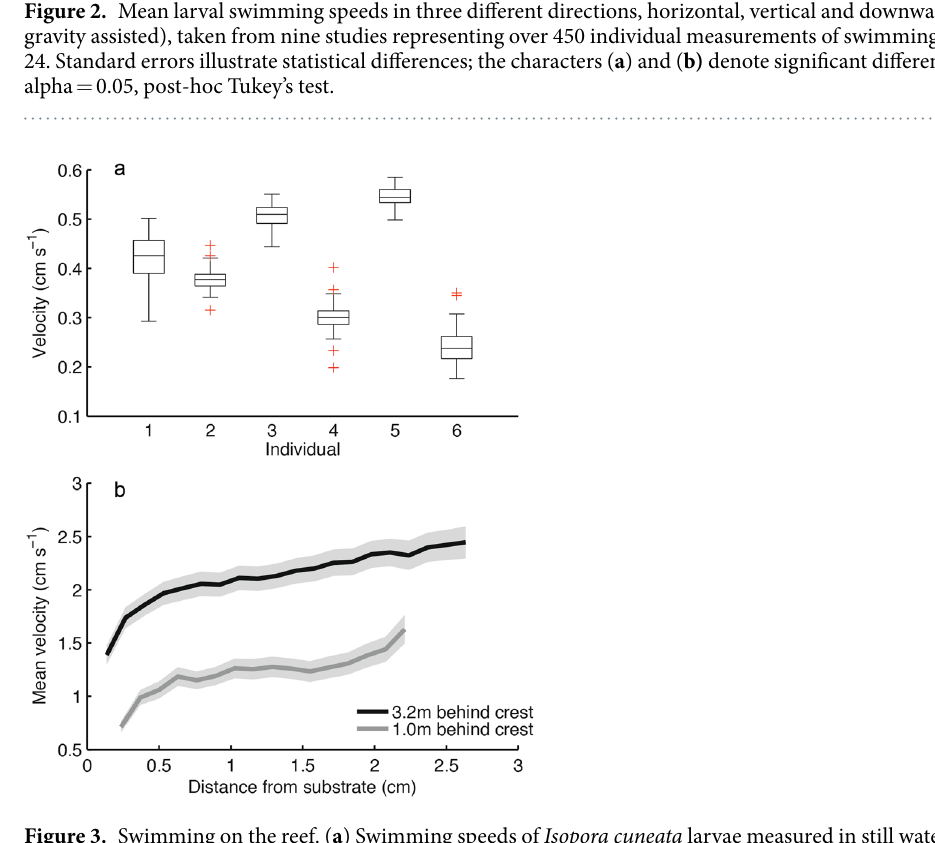
structure assists coral recovery from disturbance by facilitating both the delivery of coral larvae to the substratum and settlement. We further hypothesize that structural complexity at a larger scale 4 works in a similar way by creating turbulence to capture larvae from the water column as they flow across the reefs. In conclusion, despite the well-documented sensory capacity of coral larvae 16, 17 , their swimming speeds are much too low to enable them to navigate to suitable settlement sites under most conditions. When in the open ocean, and even on reefs, coral larvae are essentially lost at sea 10 . Furthermore, because flows that are sufficiently benign for coral larvae to swim directly to the substratum are very rare, some form of topographic structure is required to generate turbulence to capture larvae from the plankton and to deliver them to the substratum. We